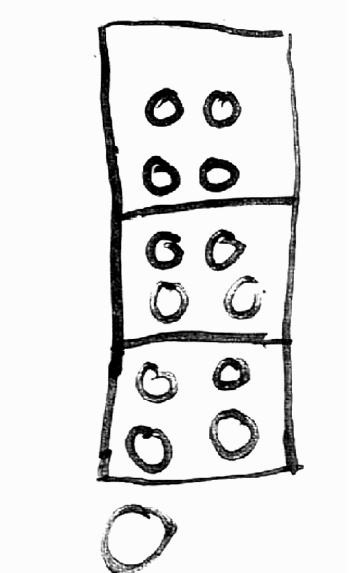
Figura 5. As partes e o resto para